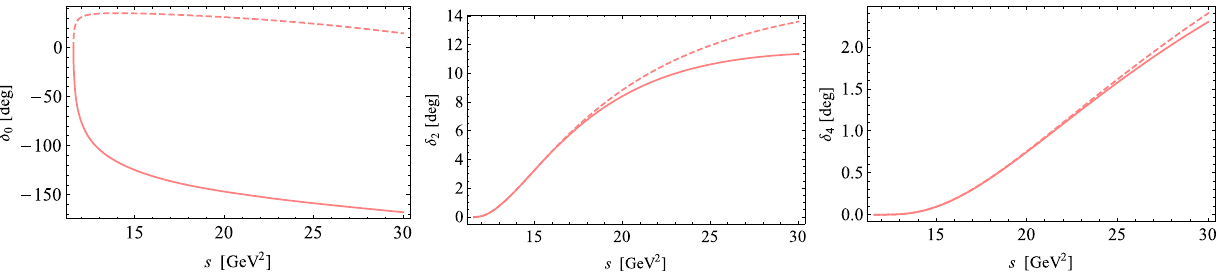
Fig. 7 Comparison of unitarized (solid) and tree-level (dash) phase shifts as function of s for (cid:2) G = 0 . 4GeV. In the three panels we show the S -, D -, and G -waves (cid:2) G , crit the behavior of the phase shift is utterly different: it starts negative already at threshold and, as a consequence